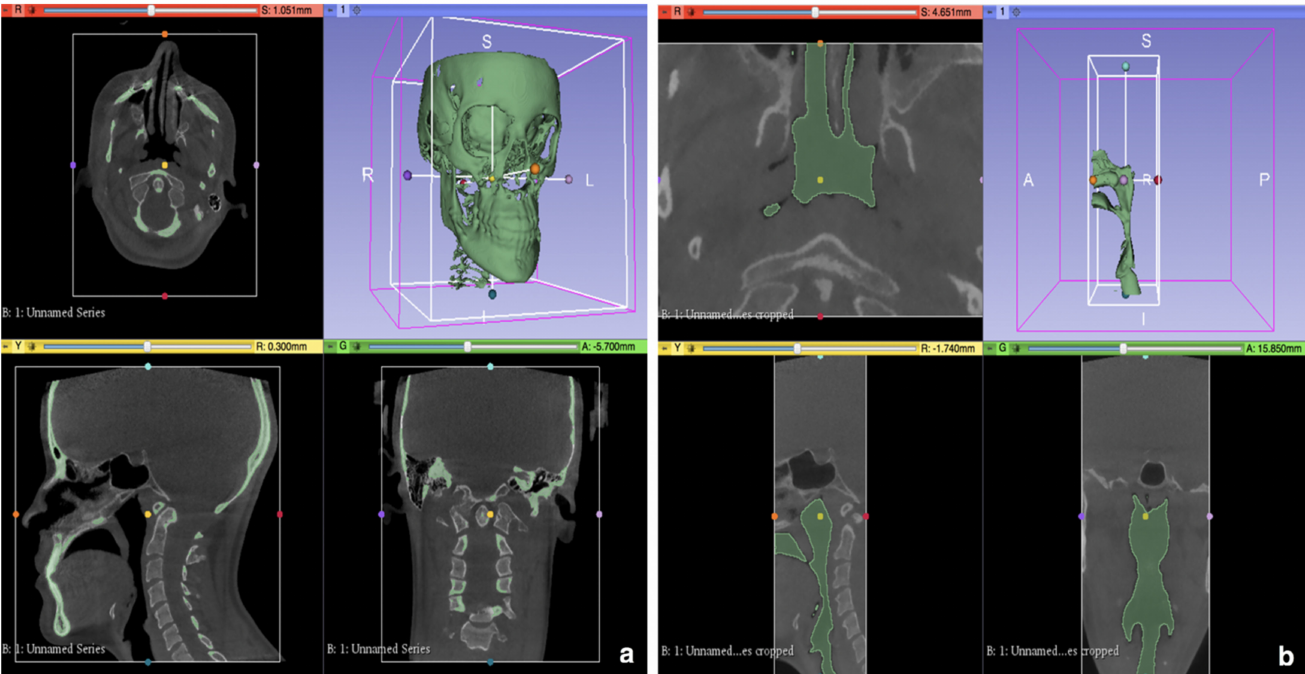
Figure 1. ( a ): Example of skull and maxillary bones segmentation in 3D Slicer software. ( b ): Example of upper airways segmentation in 3D Slicer